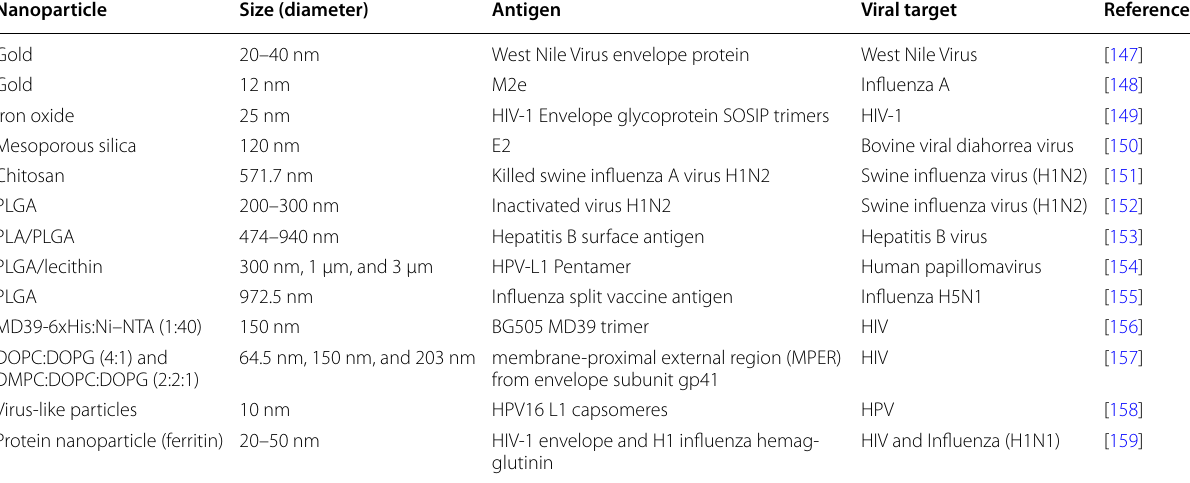
Table 2 Nanoparticle vaccines targeted towards viral antigens